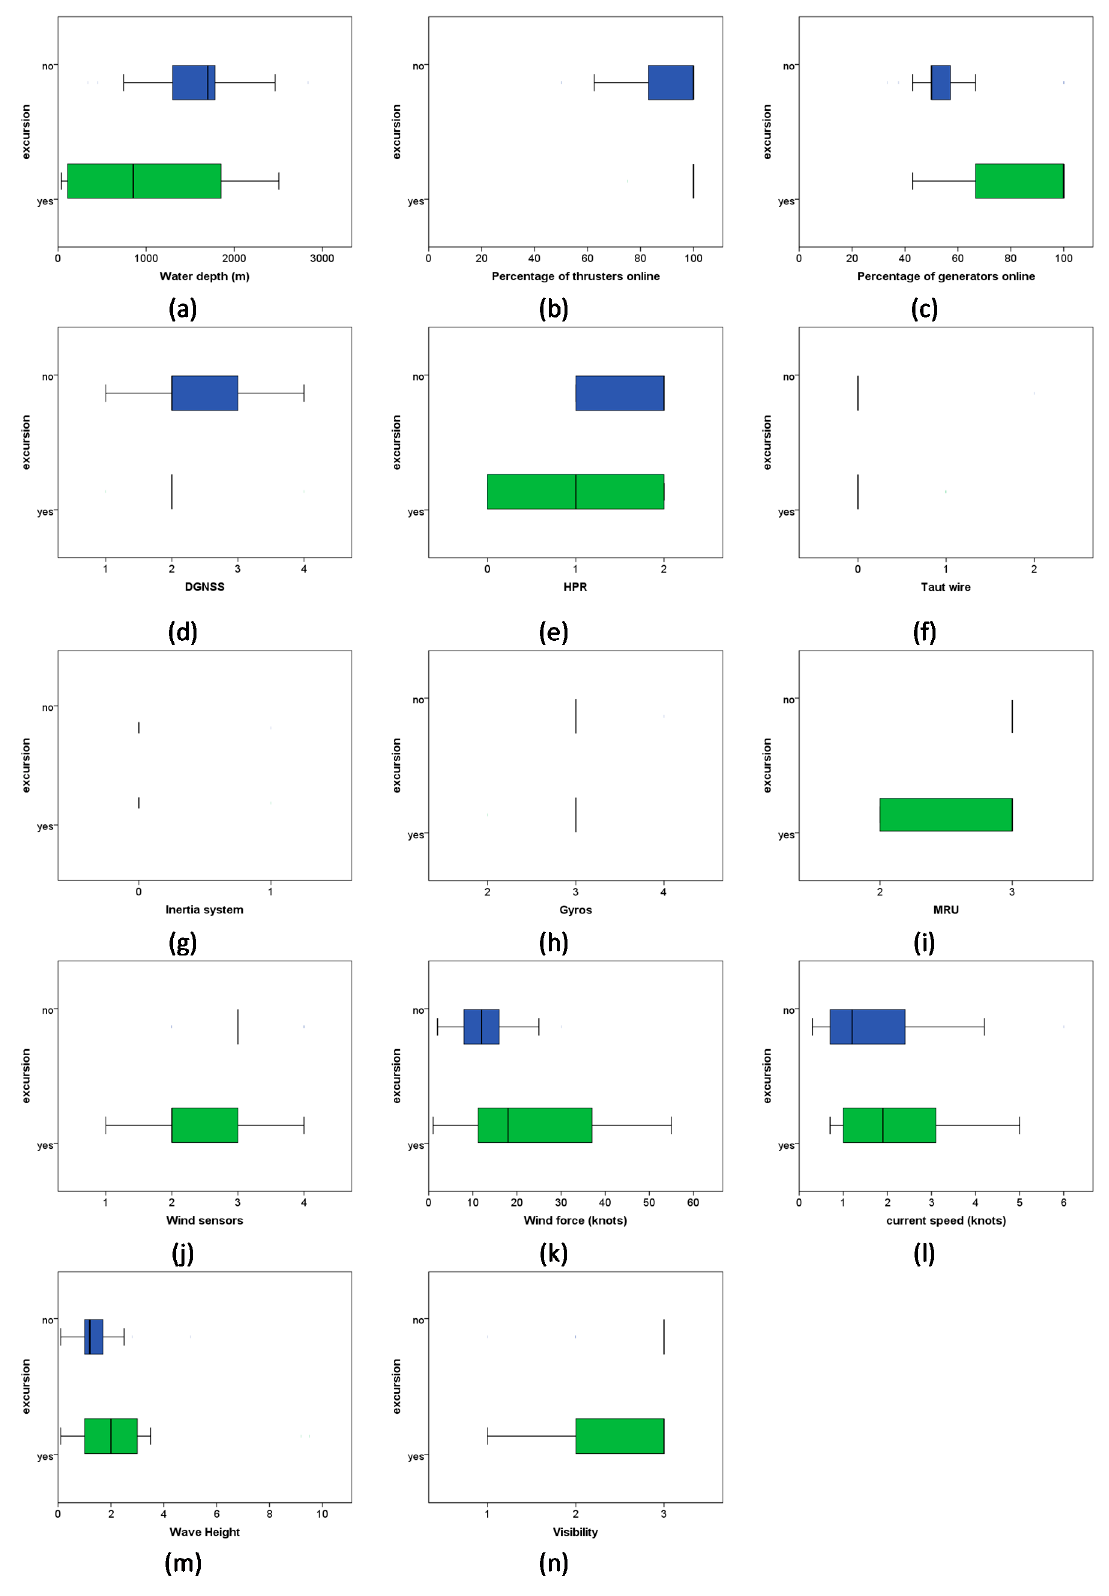
Figure 2. Distribution of the potentially relevant variables stratified by whether excursion occurred: ( a ) Water depth, ( b ) Percentage of thrusters, ( c ) Percentage of generators, ( d ) GNSS, ( e ) HPR, ( f ) Taut wire, ( g ) Inertia system, ( h ) Gyros, ( i ) MRUs, ( j ) Wind sensors, ( k ) Wind force, ( l ) Current speed, ( m ) Wave height, and ( n ) Visibility.